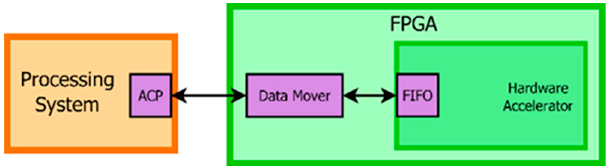
Figure 12. Block diagram of the interfacing mechanisms used by the master.